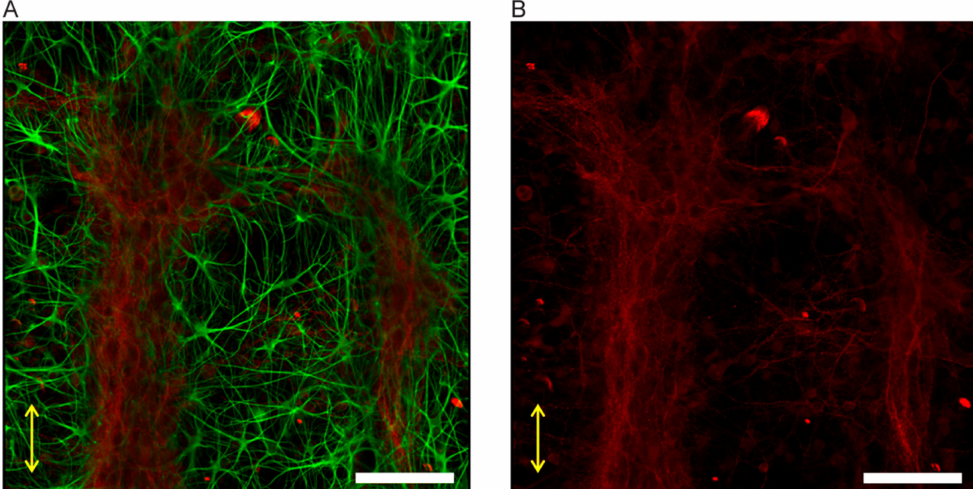
Figure 6. Neurite bundles in 3D-like culture. ( A ) Green staining indicates the GFAP for astrocytes, and red staining (shown alone in ( B )) indicates the MAP2 for neurons. The double-sided yellow arrows indicate the direction of the nanogrooves. Scale bar: 100 µ m. Adapted from Figure 5.11 in